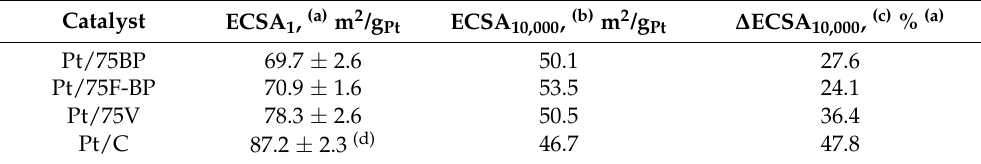
Table 4. Electrochemical performance of the reference Pt/C and Ti 0.8 Mo 0.2 O 2 -C composite-supported Pt catalysts.